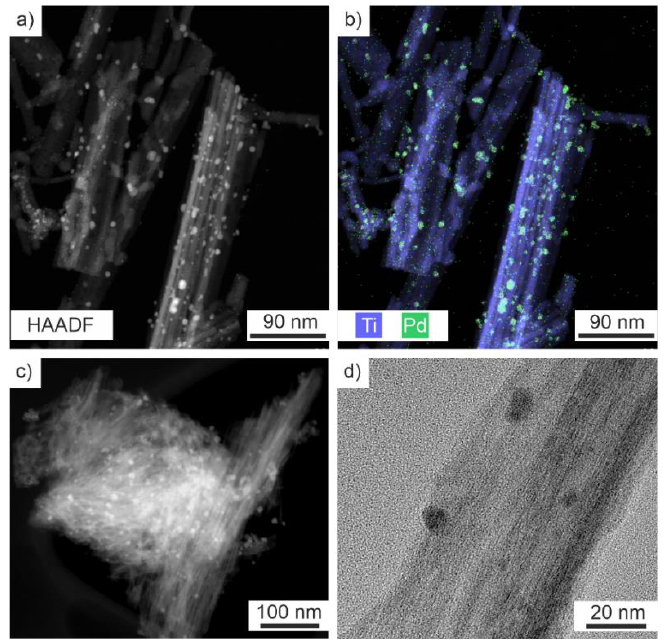
Figure 5. TEM analysis of Pd/TNTs: ( a ) HAADF-STEM image of long Pd/TNTs with ( b ) EDXS element map. ( c ) HAADF-STEM image of short Pd/TNTs with ( d ) HRTEM image.